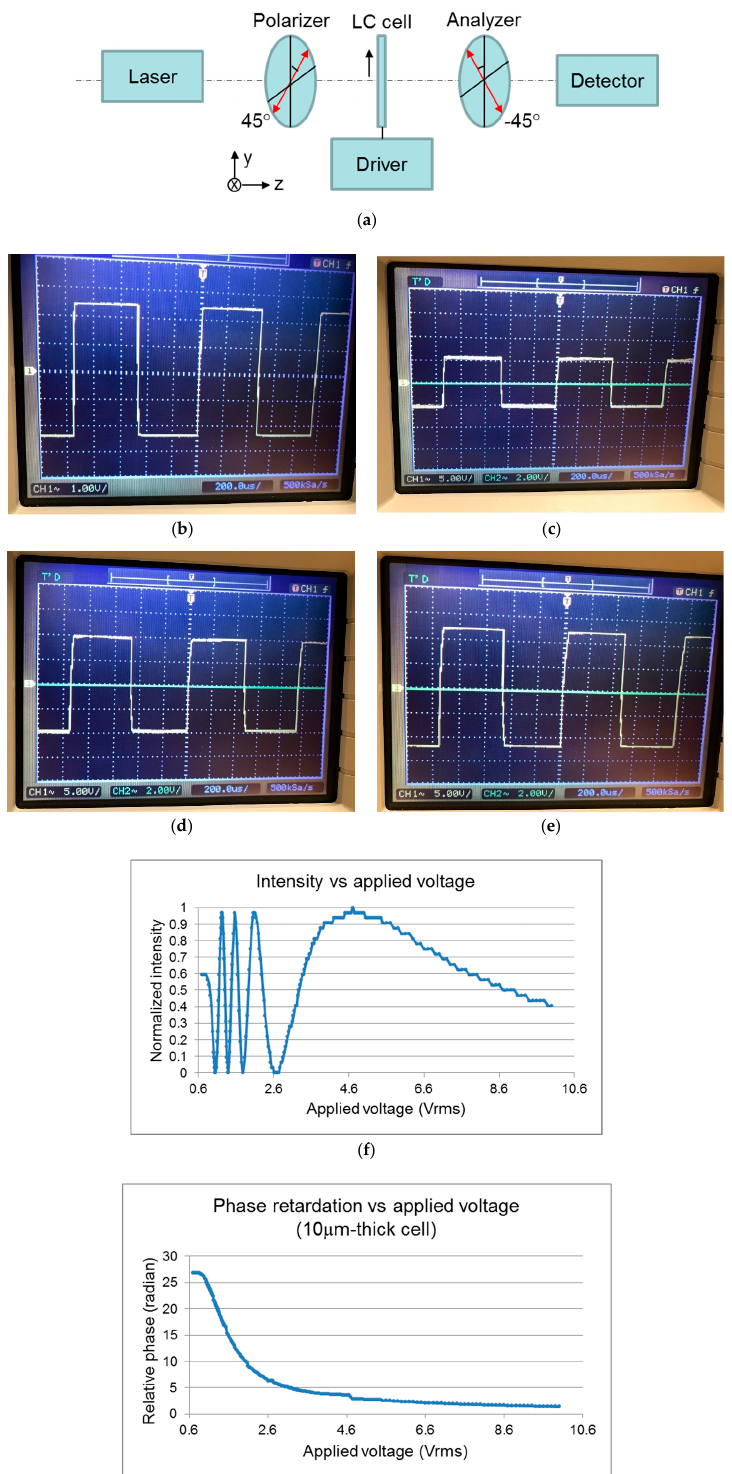
Figure 4. ( a ) Setup for testing the electro-optic response of the liquid crystal cell; ( b – e ), Some of the 1kHz waveforms (in oscilloscope screenshot) generated by the LC driver used for driving the LC cell in ( a ) with ( b )V RMS = 2.5 V; ( c ) V RMS = 5 V; ( d ) V RMS = 10 V; and ( e ) V RMS = 12.5 V; ( f ) Intensity modulation as a function of the applied voltage; ( g ) Relative phase retardation generated by the liquid crystal cell as a function of the applied voltage.